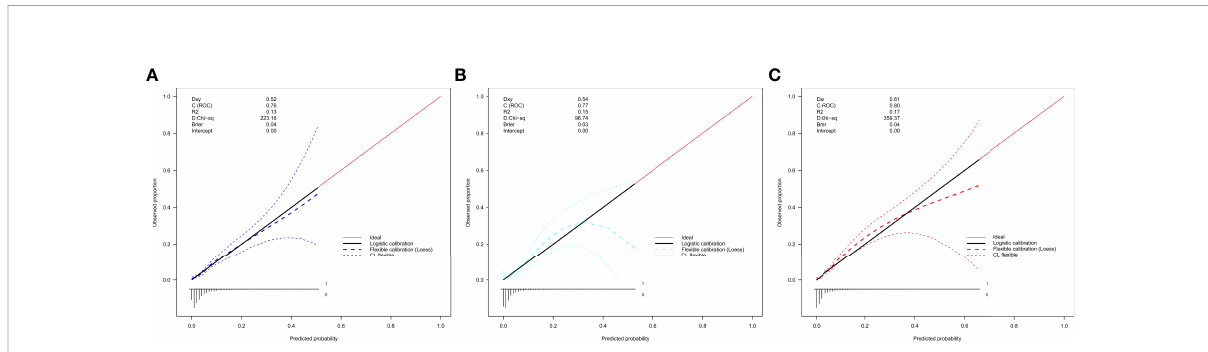
FIGURE 4 Calibration curves of the nomogram for rates of isolated high 2-hour plasma glucose in the validation datasets. (A) Development datasets (Guangzhou). (B) Internal validation datasets (Guangzhou). (C) External validation datasets (Changchun). The curves represent calibration of each model in terms of agreement between the assessed risk and observed outcomes of